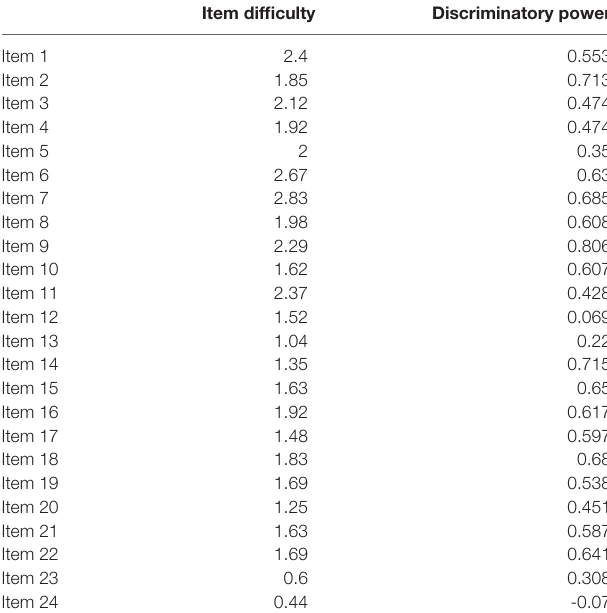
TABlE 1 | Item difficulty and discriminatory power of the